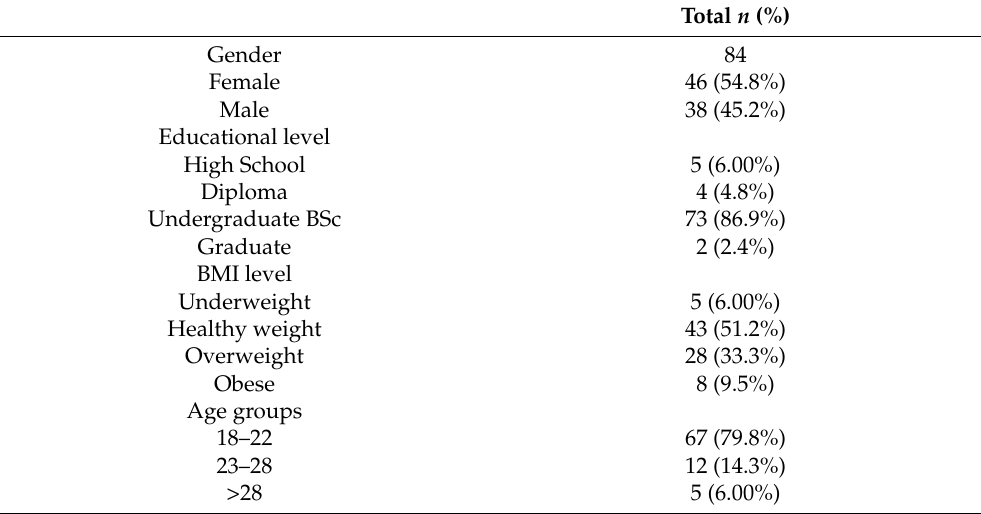
Table 1. Demographic